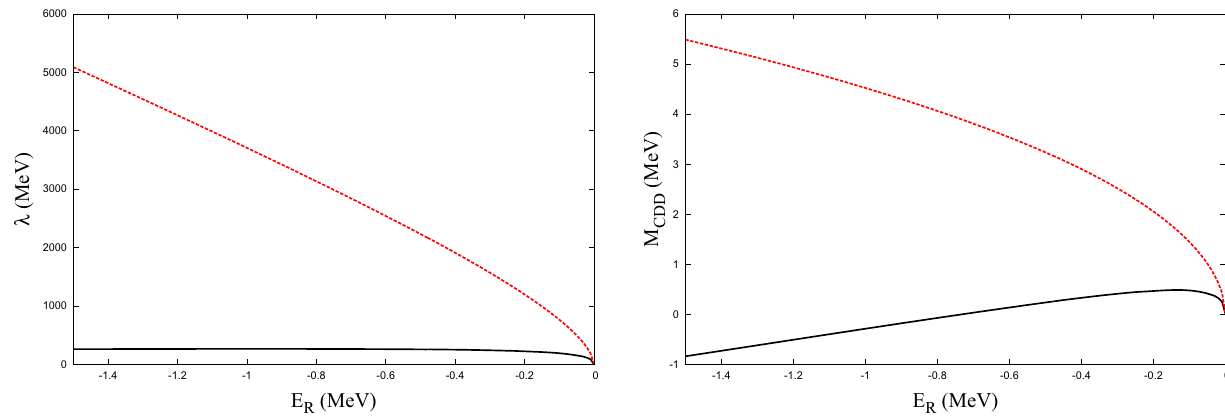
Fig. 8 The left panels shows λ and the right one M CDD as a function of E R for case 3.I ( black solid ) and case 3.II ( red dashed lines )